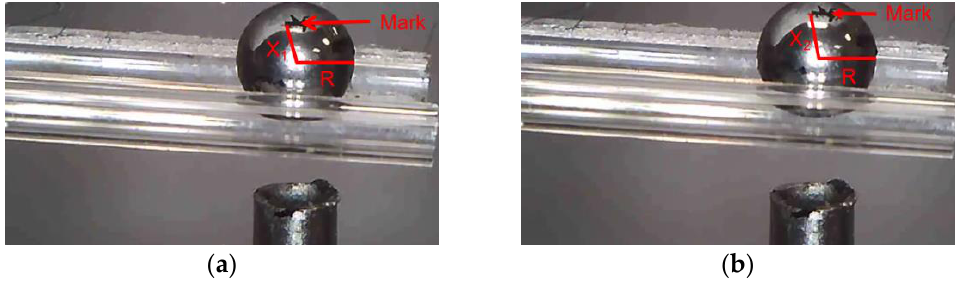
Figure 20. Before and after the rotation of the micro ball. ( a ) Before the micro ball rotates. ( b ) After the micro ball rotates. Table 2. Rotation angle of the micro-object in experiment.